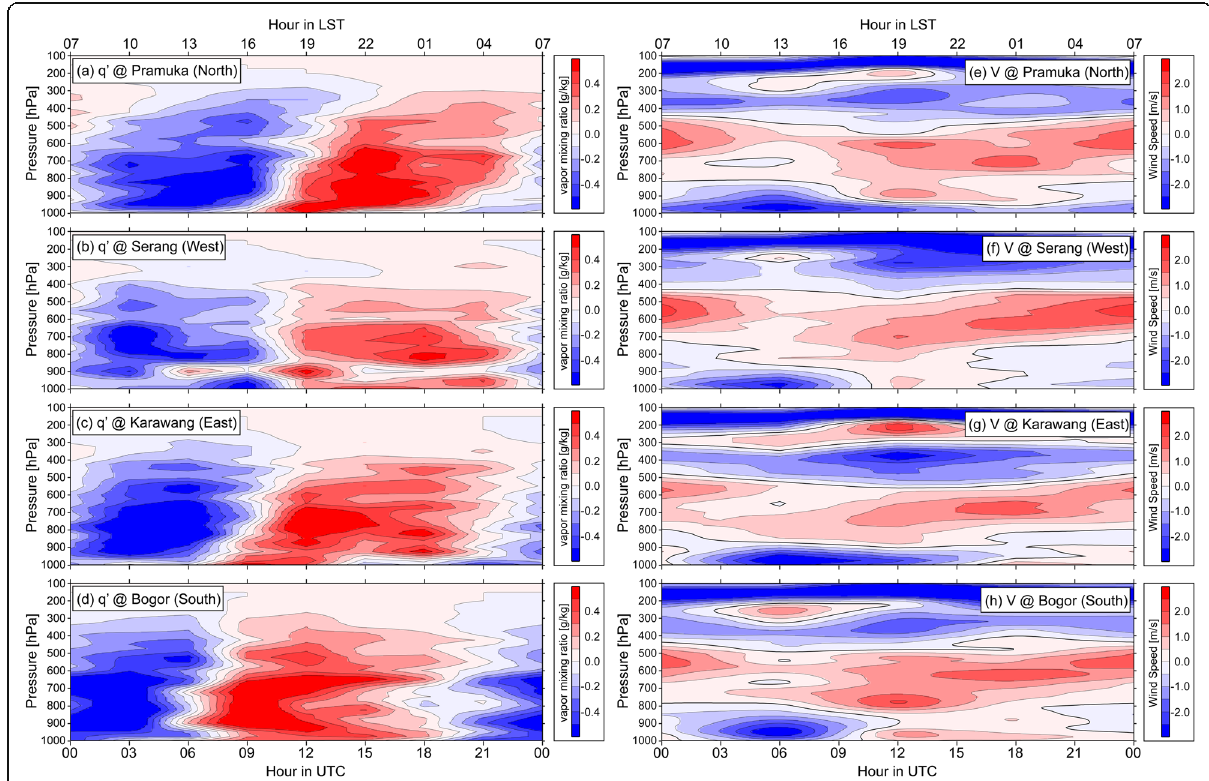
Fig. 11 Diurnal composite of the vertical cross sections, for the water vapor mixing ratio as anomaly from the 1-day running mean ( a to d ) and for the meridional wind (absolute value) ( e to h ) at each sounding site; Pramuka ( a and e ), Serang ( b and f ), Karawang ( c and g ), and Bogor ( d and h